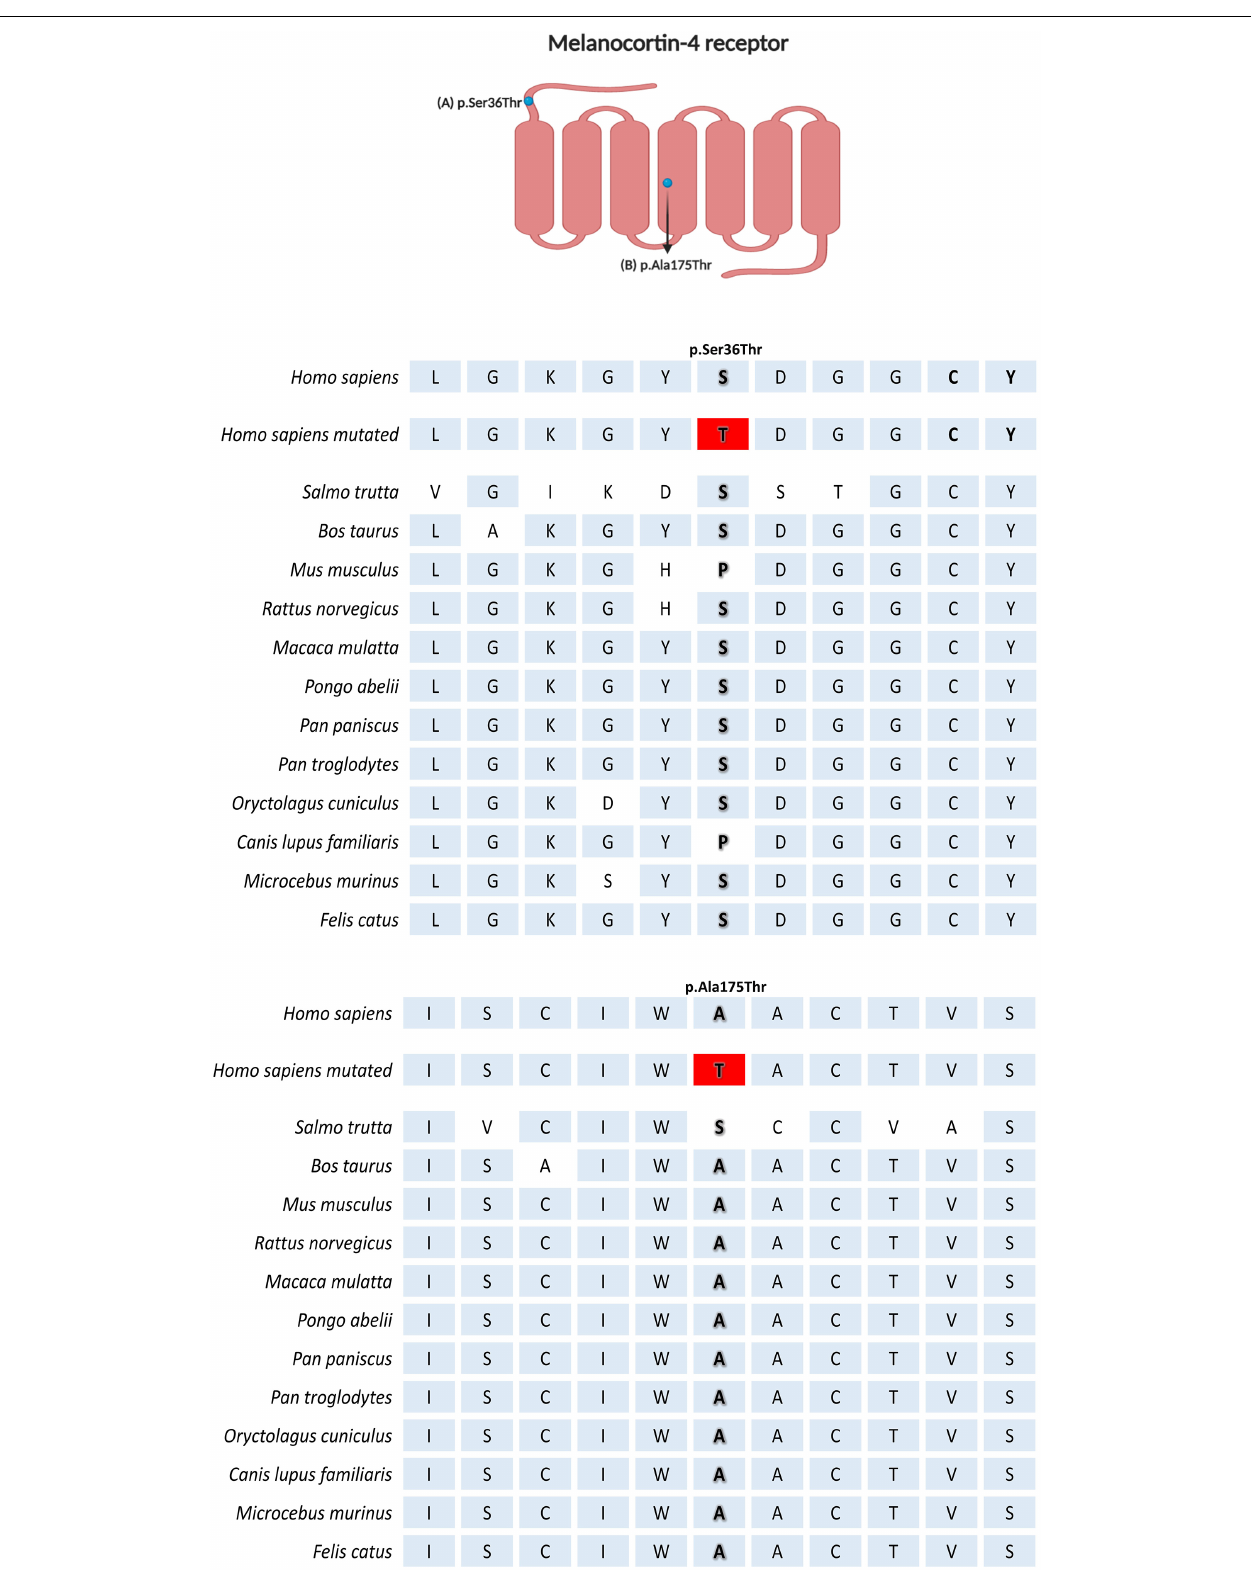
FIGURE 1 | Multiple sequence alignment comparison of MC4R across the species by Clustal Omega (1.2.4). Created with BioRender.com.